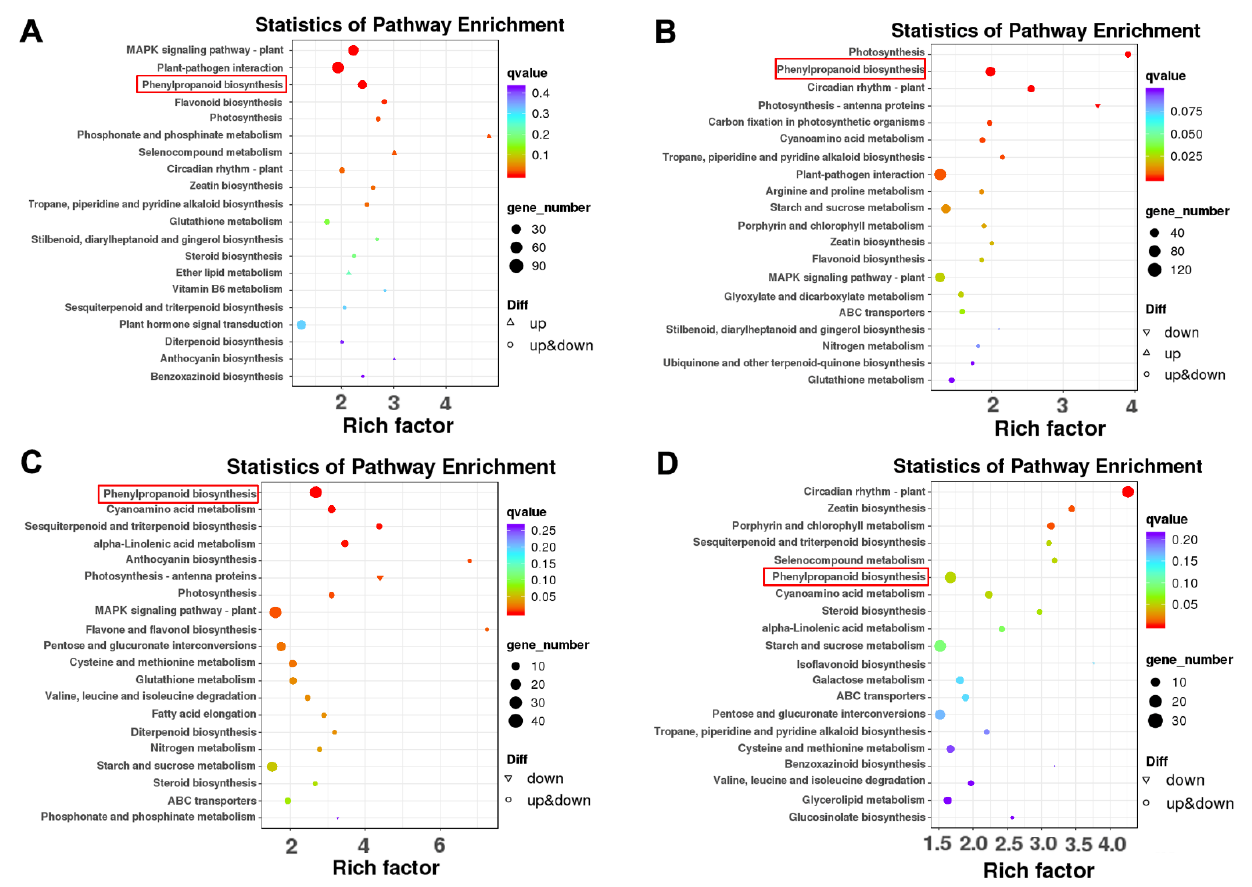
Figure 6. The top 20 enriched KEGG pathways enrichment analysis of DEGs in the four comparison groups. ( A – D ) KEGG pathway enrichment analysis of DEGs in the WT-CK vs. OX3-CK, WT-CK vs. WT-N, OX3-CK vs. OX3-N, and WT-N vs. OX3-N comparisons, respectively.